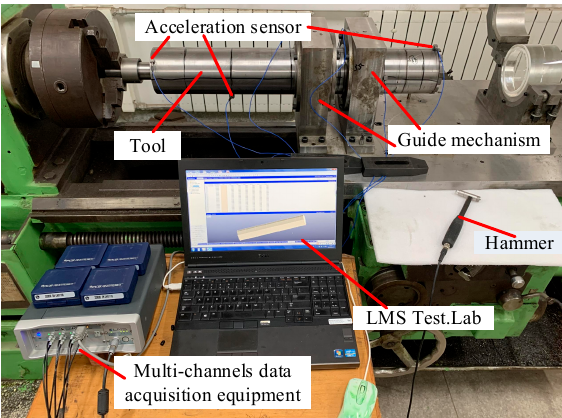
Figure 5. Sensor layout position and experimental site.